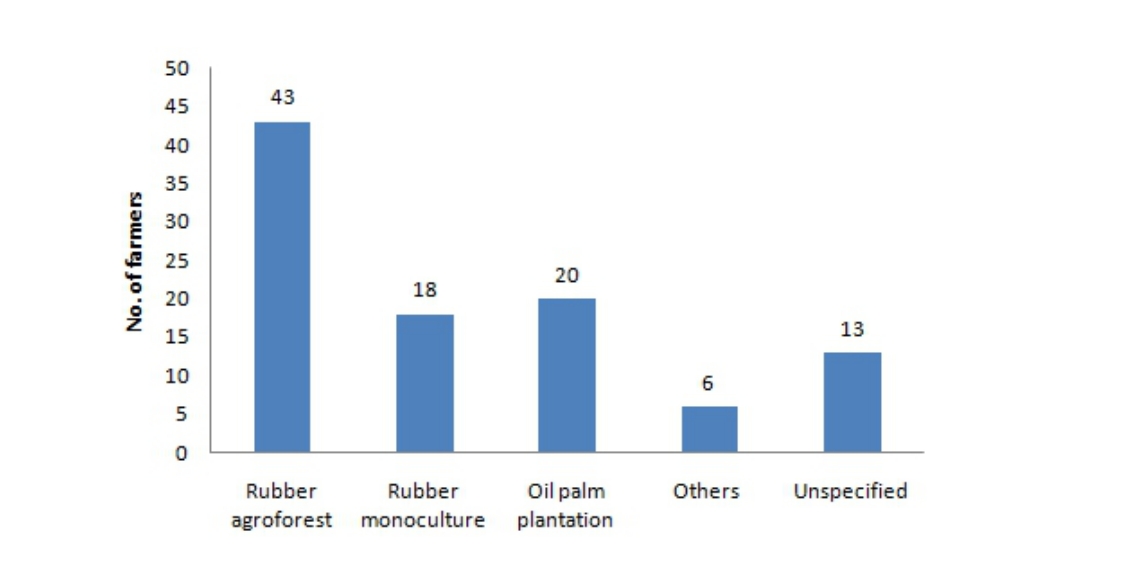
Fig. 6. Preferred land use to support agro-biodiversity conservation, 2010 in Jambi